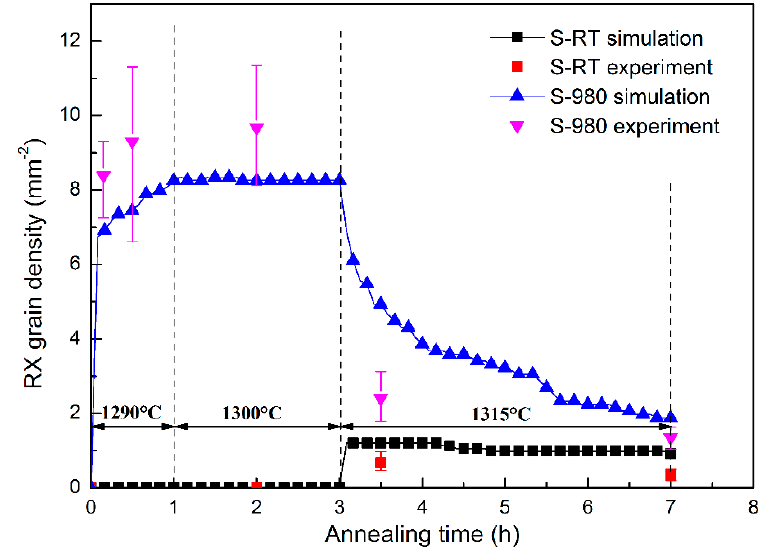
Figure 11. Variation of simulated and experimental grain density with annealing temperature and holding time during SSHT process.